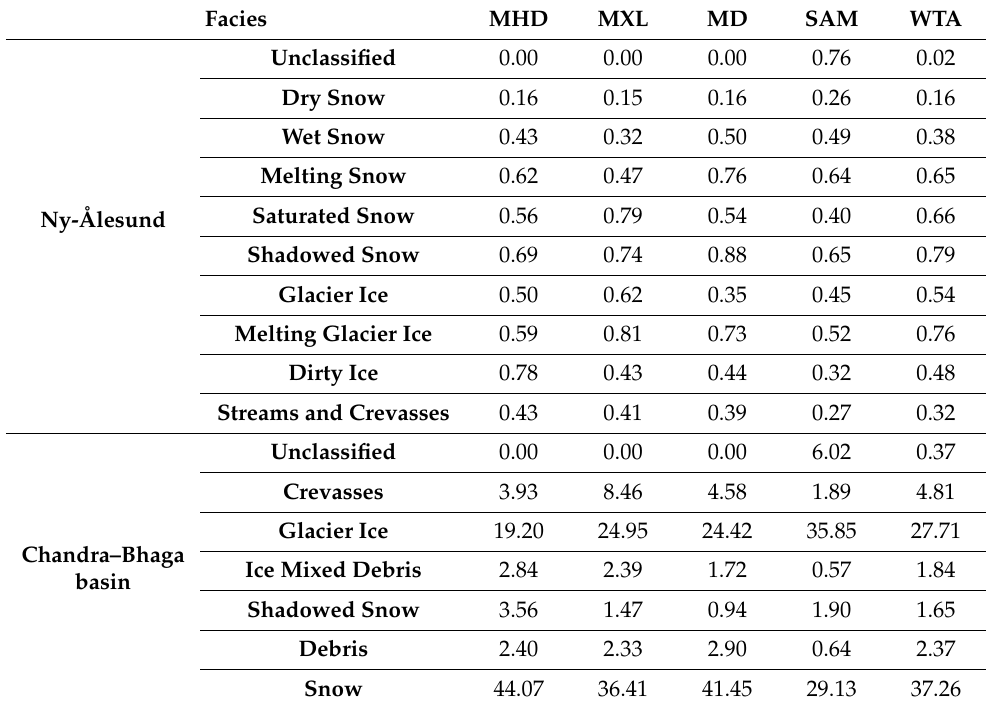
Table 8. Classified area of each facies as an average of the results for all CC classification algorithms for each processing